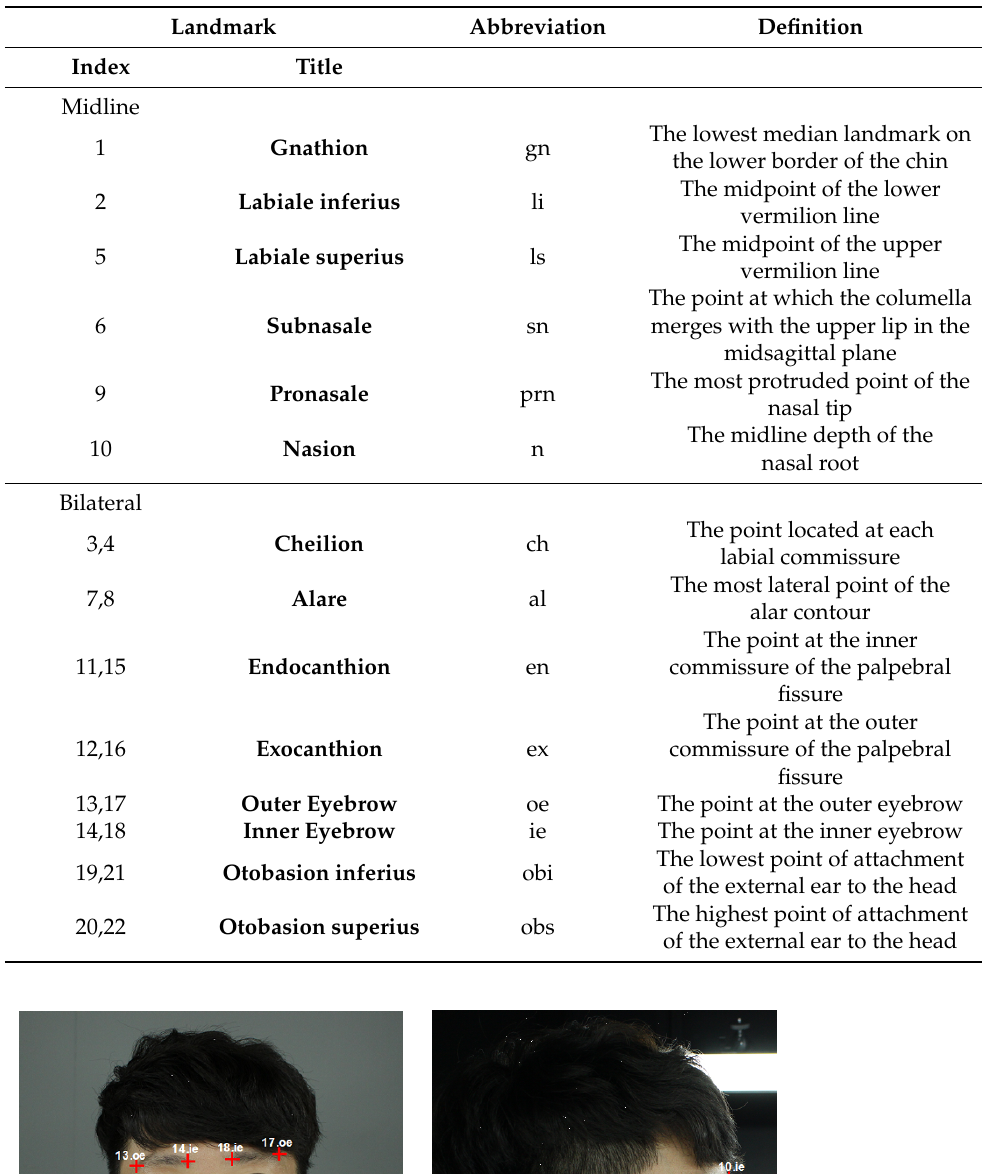
Table 1. Frontal pose facial landmark index numbers and definitions [2,7,20,53].